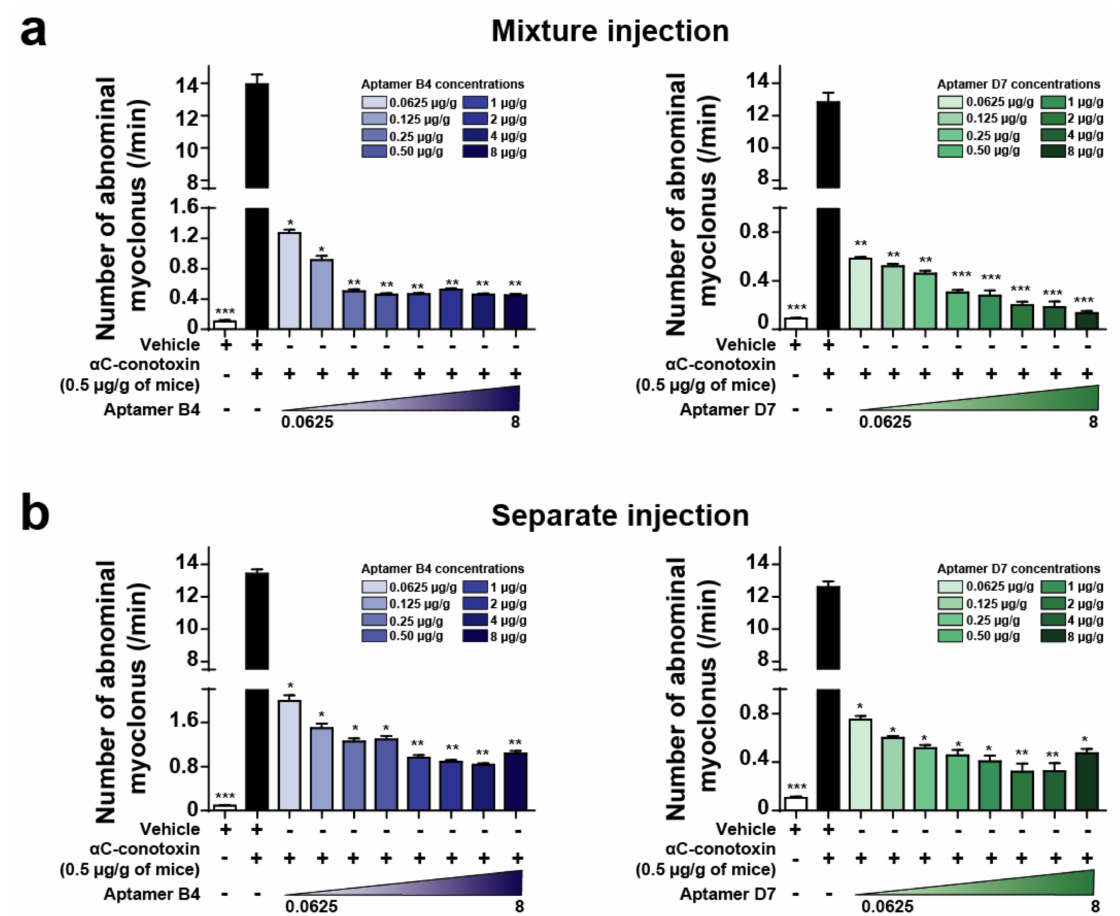
Figure 3. Aptamer neutralization of α C-conotoxin PrXA-induced myoclonus. ( a ) Number of abdominal myoclonus per min after α C-conotoxin PrXA injection alone or combined with increased concentrations of aptamers B4 ( left , bleu) or D7 ( right , green). n = 6 mice for each condition. ( b ) Number of abdominal myoclonus per min after α C-conotoxin PrXA injection alone or followed by increased concentrations of aptamers B4 ( left , blue) or D7 ( right , green). n = 6 mice for each condition. One-way ANOVA, * p < 0.05, ** p < 0.01, *** p < 0.001 versus α C-conotoxin PrXA injection alone (black